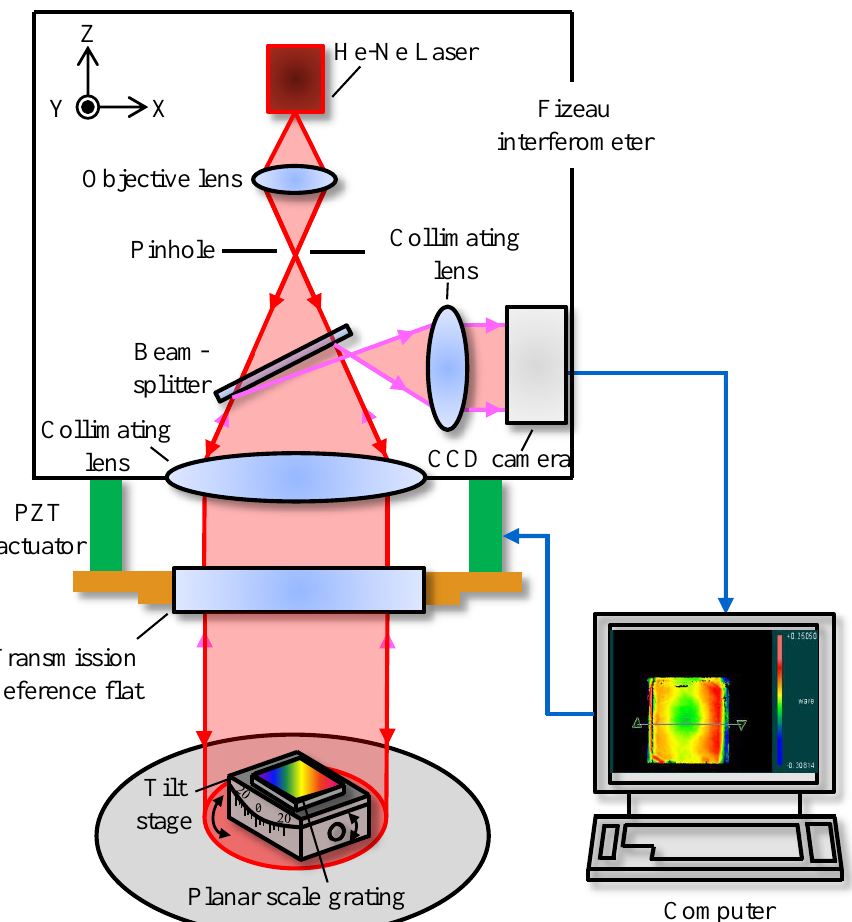
Figure 3. Experiment setup with a Fizeau interferometer. PZT: piezoelectric ceramic transducer; CCD: charge-coupled Device.